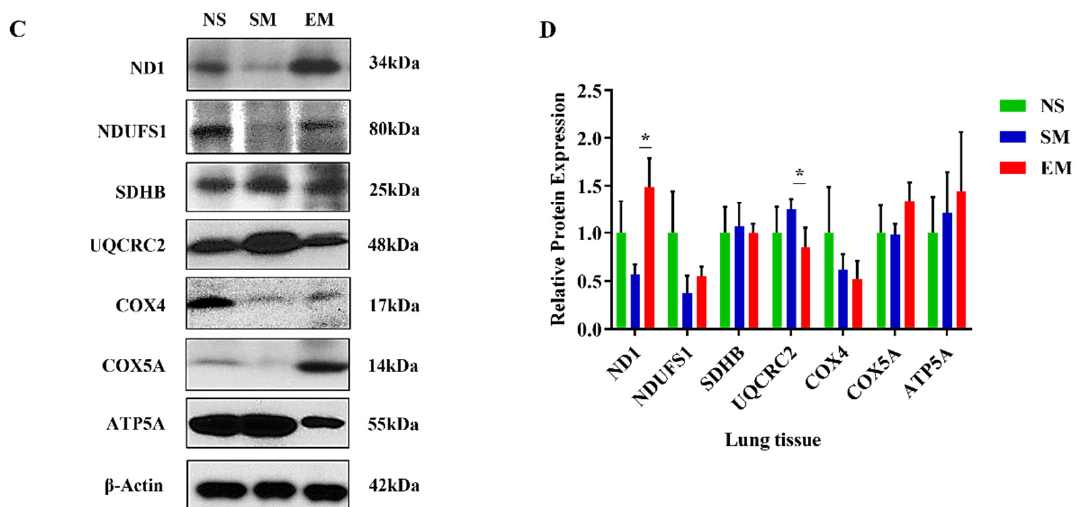
Figure 1. Reduced expression of mitochondria-encoded genes in lung tissue in smokers and emphy- sema. The expression of mitochondria-encoded ( A ) and nuclear-encoded ( B ) mitochondrial genes was determined by RT-PCR in lung tissue obtained from control nonsmokers (NS), smokers (SM), and patients with emphysema (EM). Mitochondrial protein levels were assessed by Western blotting ( C ), quantified, and normalized to β -actin expression ( D ). Data are shown as means ± s.e.m (N = 4–10 per group; * p < 0.05; ** p < 0.01).